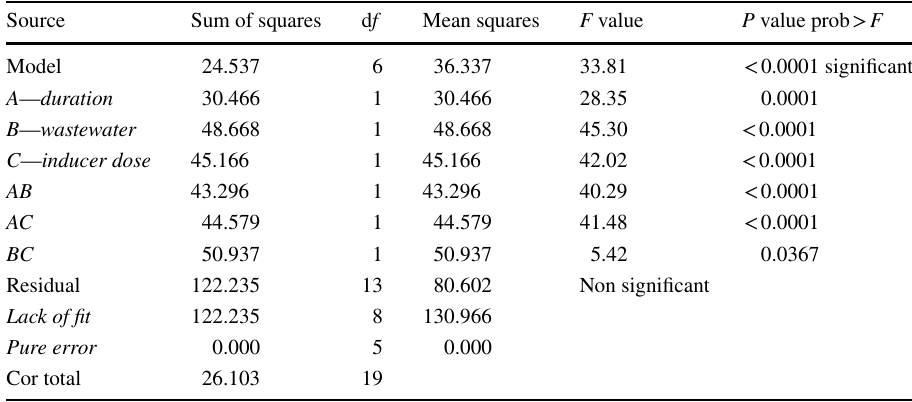
Table 4 ANOVA results for the response surface quadratic model for the laccase activity R 2 = 0.9398, Adj. R 2 = 0.9120, Pred. R 2 = 0.7958